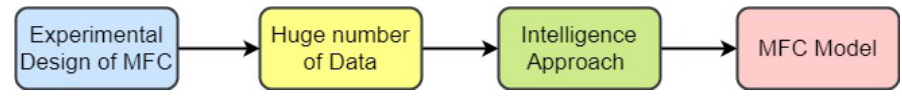
Figure 6. MFC Modeling using an Intelligence Approach.